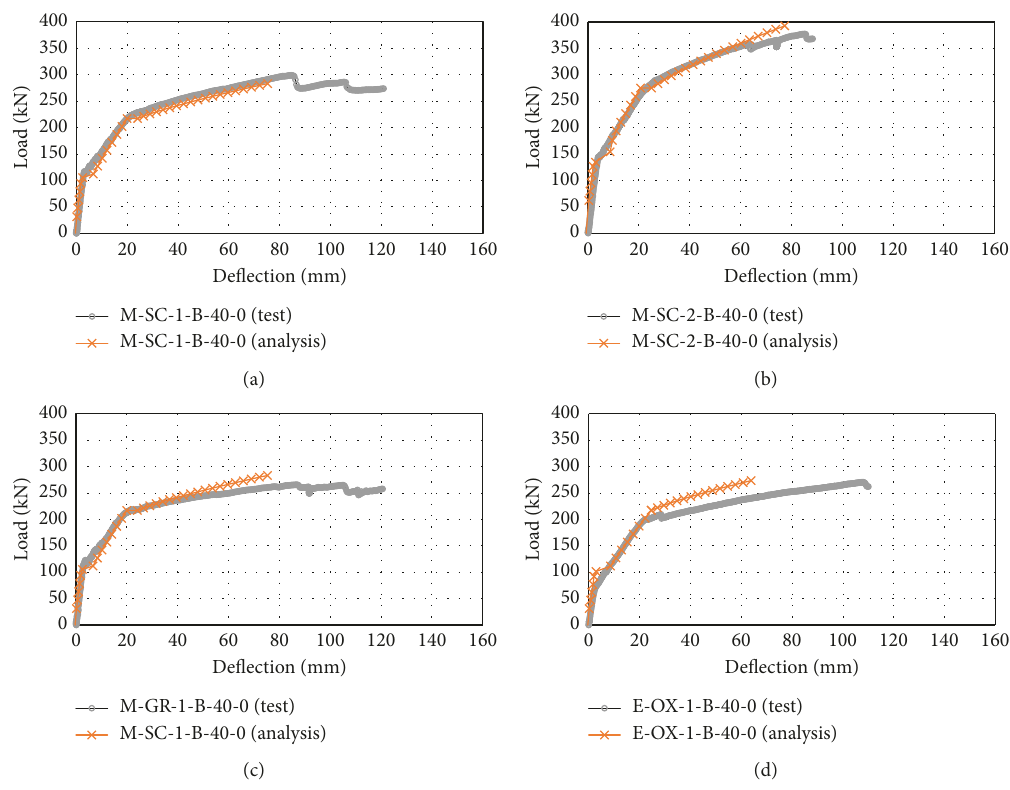
Figure 26: Measured load-strain curves. (a) M-SC-1-B-40-0. (b) M-SC-2-B-40-0. (c) M-GR-1-B-40-0. (d)